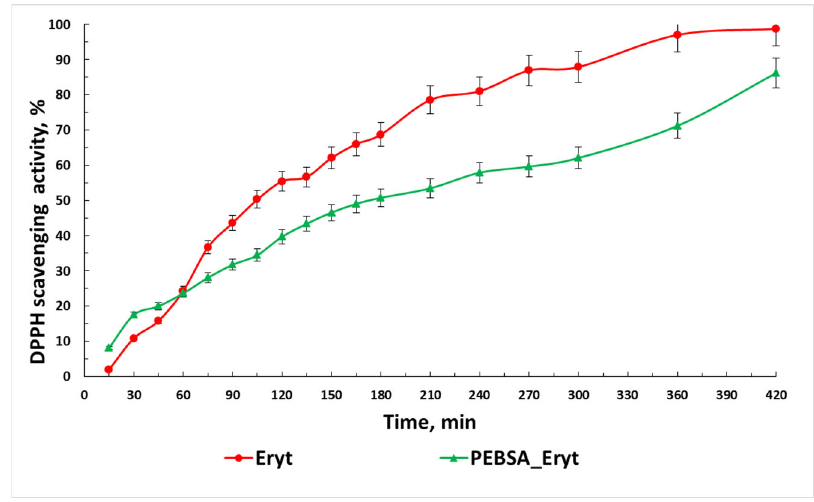
Figure 11. The scavenging activity percentage of Eryt and PEBSA_Eryt samples.